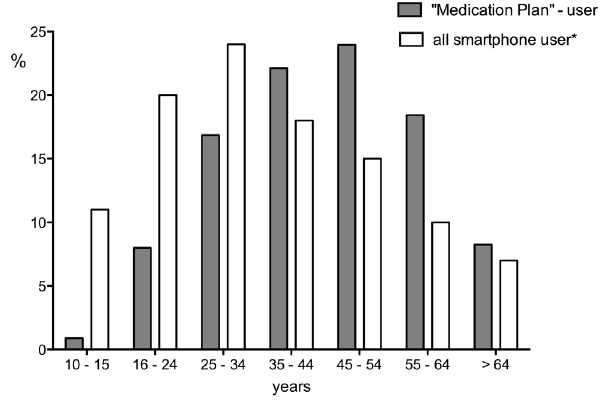
Figure 2. Relative proportion by age of users of "Medication Plan" who provided demographic data (n=2279) and all smartphone users (*Federal Statistical Office, 2011 [ 11 ] ).